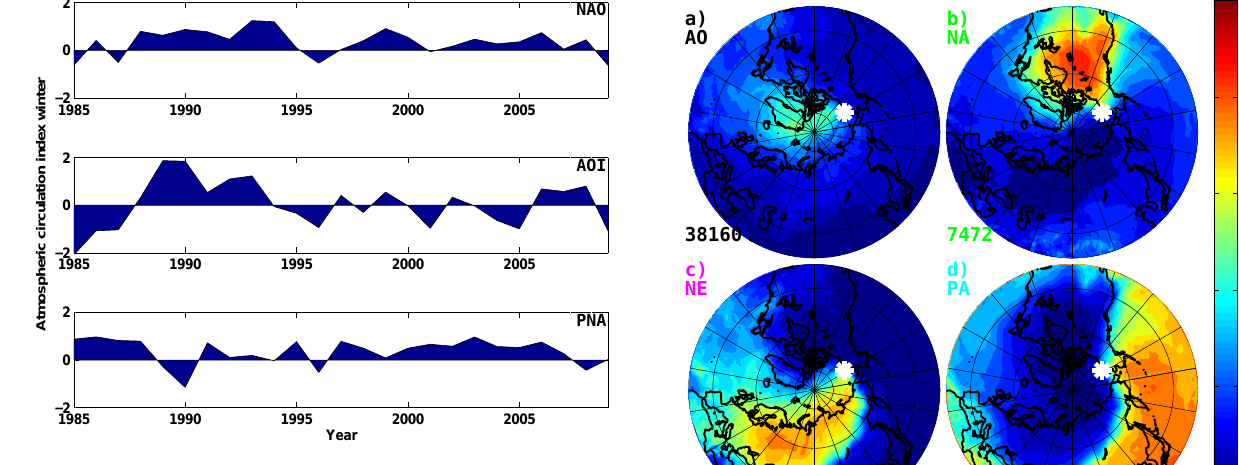
Fig. 6. Annual variation of the atmospheric circulation indices NAO, AOI, and PNA during the winter season.